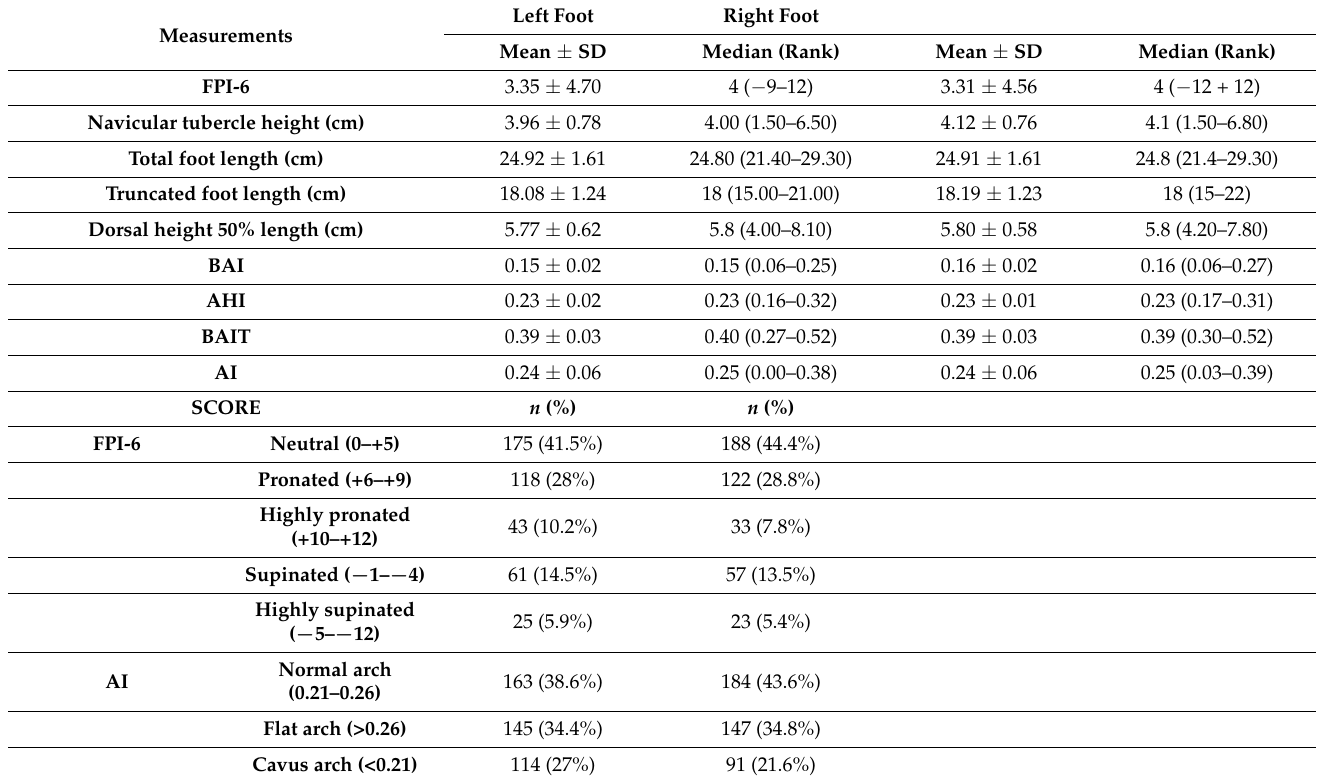
Table A2. Descriptive values of Foot Posture Index 6, anthropometric measurements of MLA and arch index on both